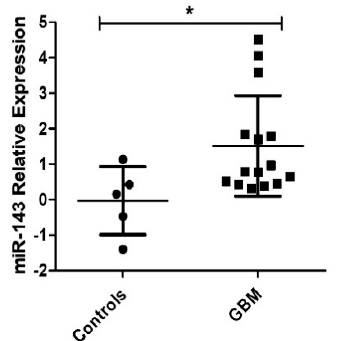
Figure 1. MiR-143 expression levels in GBM. Formalin-fixed paraffin-embedded (FFPE) tissue blocks from 19 newly diagnosed Glioblastoma (GBM) patients (13 females, 6 males) and 5 control patients (2 females, 3 males) were used in this study. GBM patients showed higher miR-143 expression compared to control patient samples (* p < 0.05); dots represent the means of triplicates ± SD.